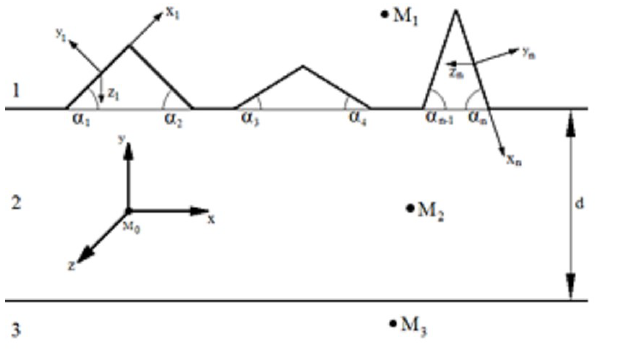
Fig. 1. Geometry of the problem under consideration: М 0 – radiation source; 1 – air half-space, 2 – ice layer, 3 – water half-space; d – ice layer